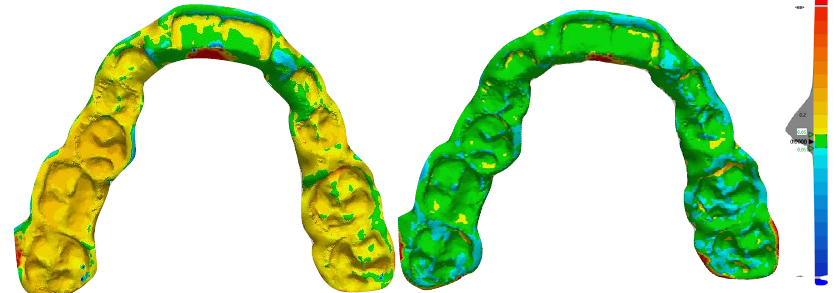
Figure 5. Example of deviation analysis detected after superimposition of the 3D-printed splint (left) and milled splint (right) with the original digital project (evaluation of the trueness).